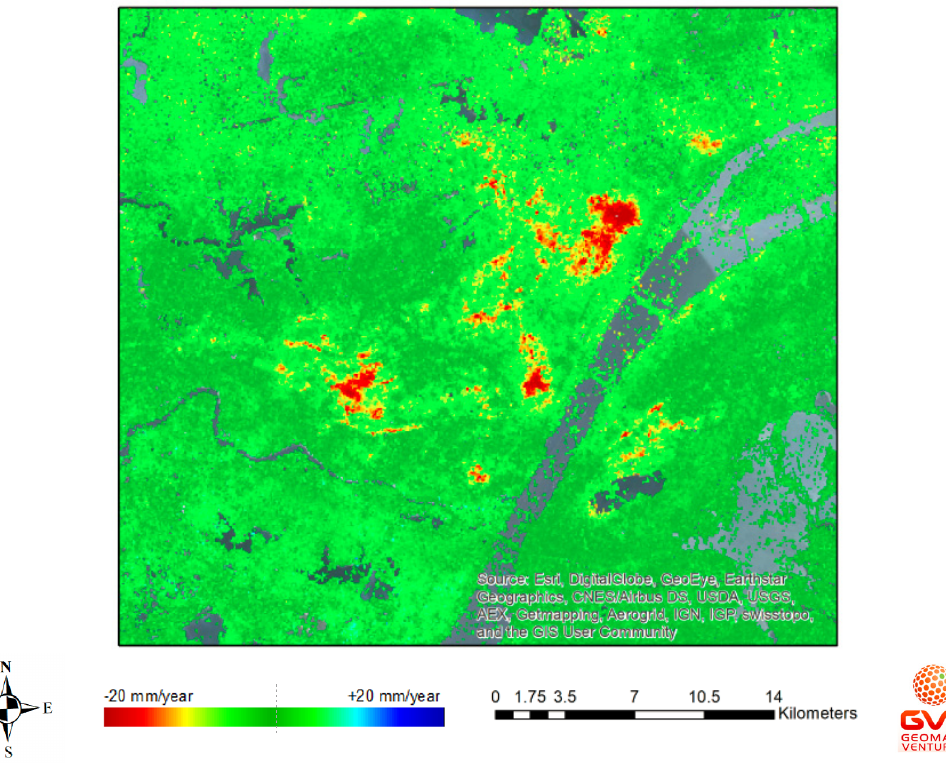
Figure 25. InSAR image processing of the area around the Erqi Bridge, China (September 2017).